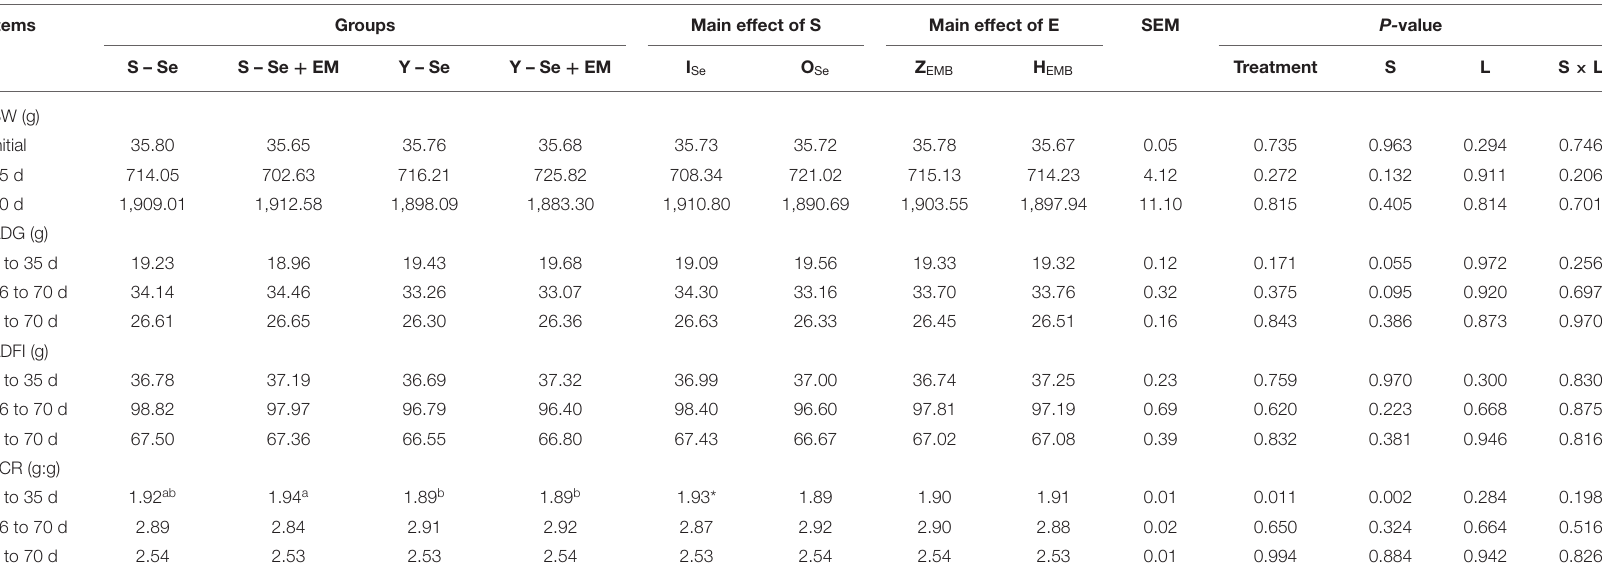
TABLE 4 | Effects of different Se sources and different bacteria supplementation levels on the growth performance of three-yellow chickens. Items